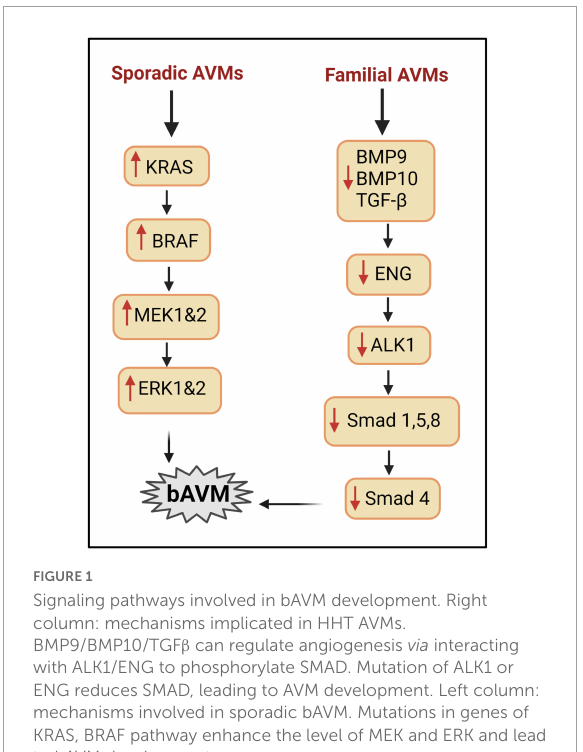
FIGURE1 Signaling pathways involved in bAVM development. Right column: mechanisms implicated in HHT AVMs. BMP9/BMP10/TGF β can regulate angiogenesis via interacting with ALK1/ENG to phosphorylate SMAD. Mutation of ALK1 or ENG reduces SMAD, leading to AVM development. Left column: mechanisms involved in sporadic bAVM. Mutations in genes of KRAS, BRAF pathway enhance the level of MEK and ERK and lead to bAVM